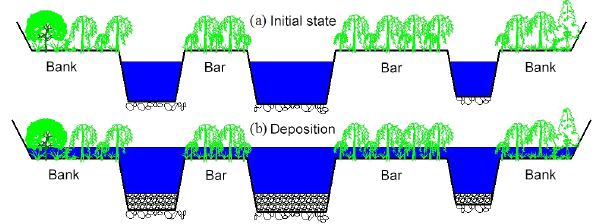
Figure 8. Sketch of branching channel deposition and stage increas- ing in flood season in the Maqu reach.